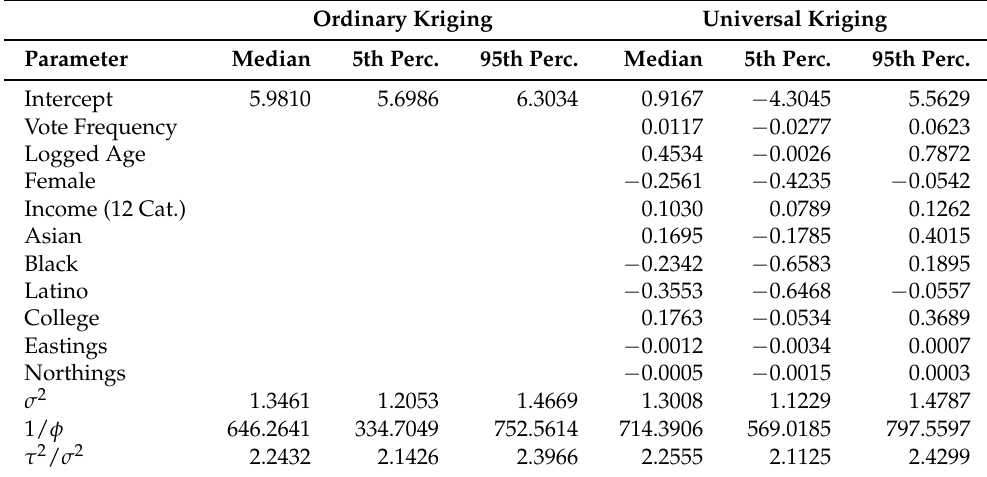
Table 2. Kriging Models of Logged Left-of-Center